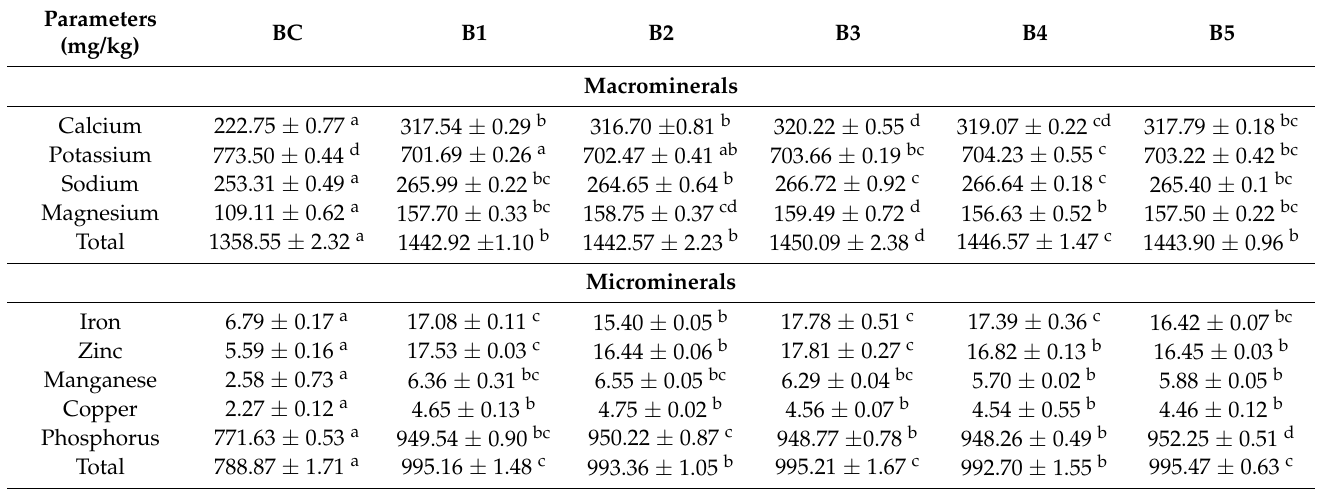
Table 6. The macro and microminerals content of developed cookies.